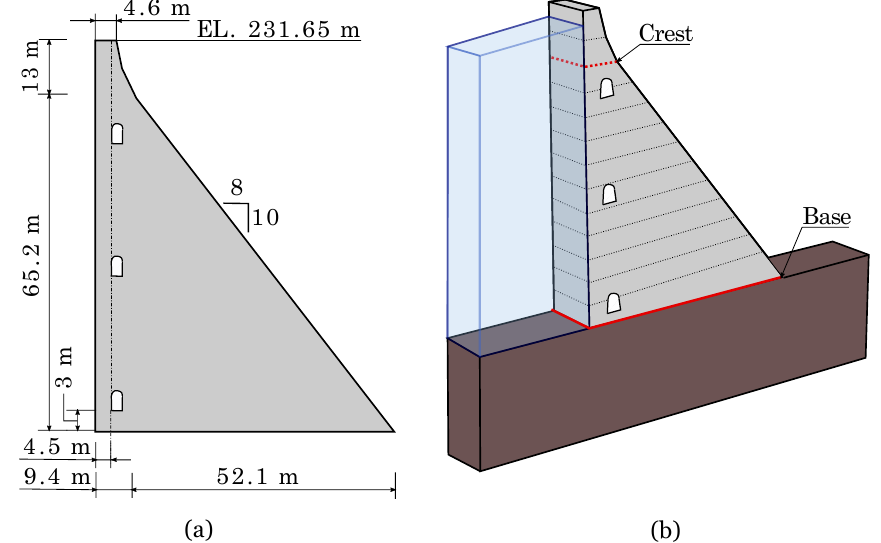
Figure 3. Case study dam: ( a ) cross-section and ( b ) CADAM3D numerical model of the tallest